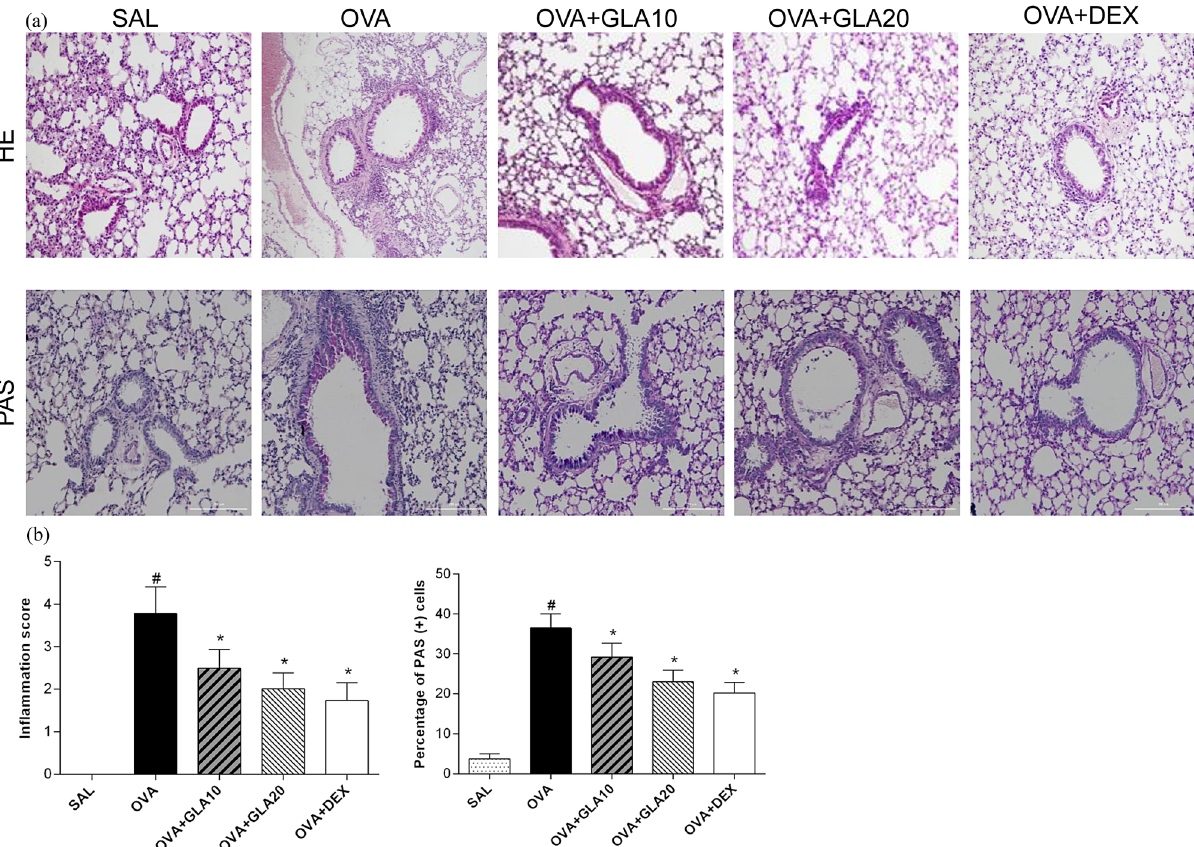
Figure 5: E ff ects of GLA on histological changes in lung tissues of OVA - sensitized asthmatic mice. ( a ) Lung sections were stained with H&E ( 200 ×) to measure the in fl ammatory cell in fi ltration and stained with PAS ( 400 ×) to detect the goblet cell hyperplasia, in the SAL, OVA - sensitized, Dex ( 1 mg/kg ) , and 10 and 20 mg/kg GLA groups. ( b ) In fl ammation score and percentage of PAS (+) cells. # P < 0.05 vs the control mice, * P < 0.05 vs the OVA mice. N = 3; analyzed by